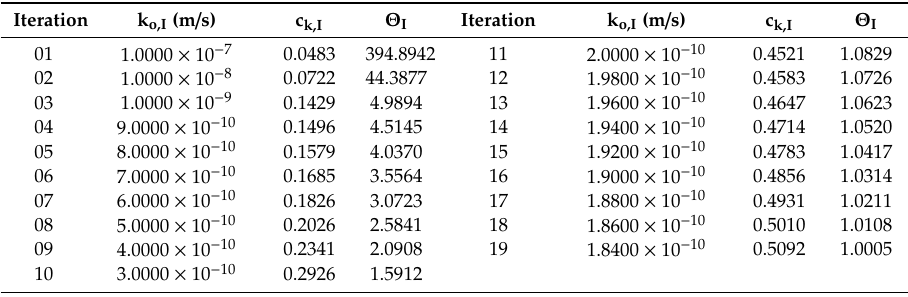
Table 4. First application. Partial results of k o,I , c k,I and Θ I throughout the iteration process.